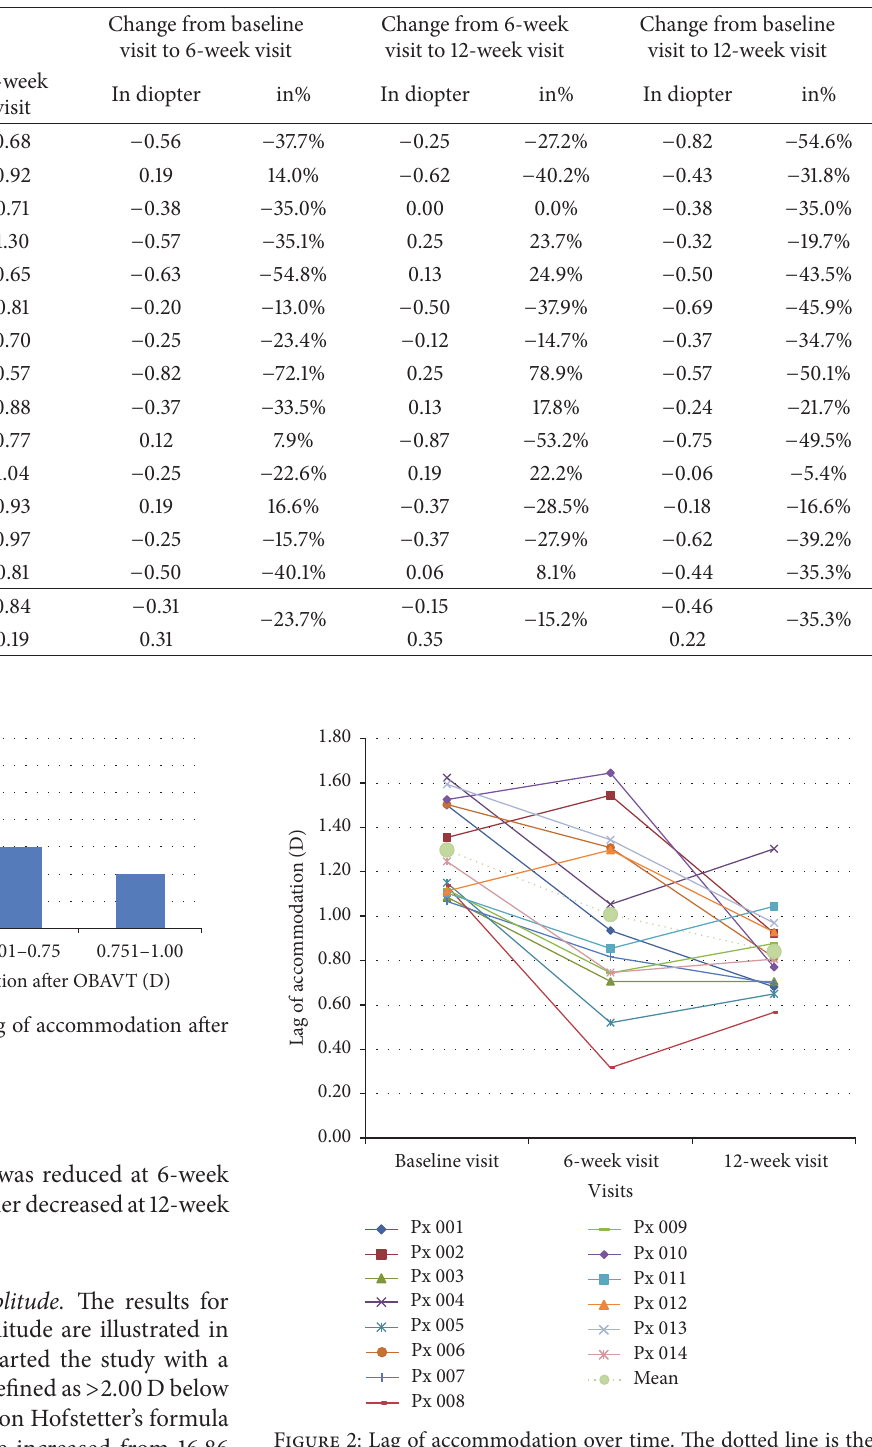
Table 2: Result and comparison of lag of accommodation values at different visits.